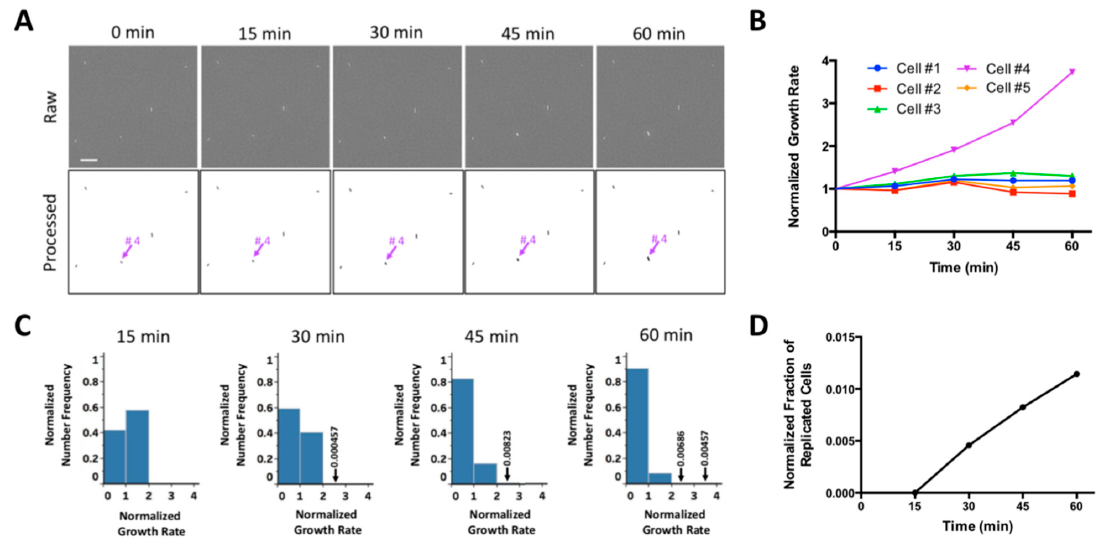
Figure 5. ( A ) Time-lapse images of one representative area, where kanamycin resistant E. coli and susceptible E. cloacae cells coexist in the presence of 50 µ g / mL of kanamycin and corresponding post-processing binary images. Scale bar, 10 µ m. Actively growing cells are marked with purple arrows. ( B ) Single-cell growth rate of bacterial cells shown in ( A ). ( C ) Number-based distribution of normalized single-cell growth rate for several thousand mixed bacterial cells treated with 50 µ g / mL of kanamycin. ( D ) Normalized fraction of replicated cells versus time.